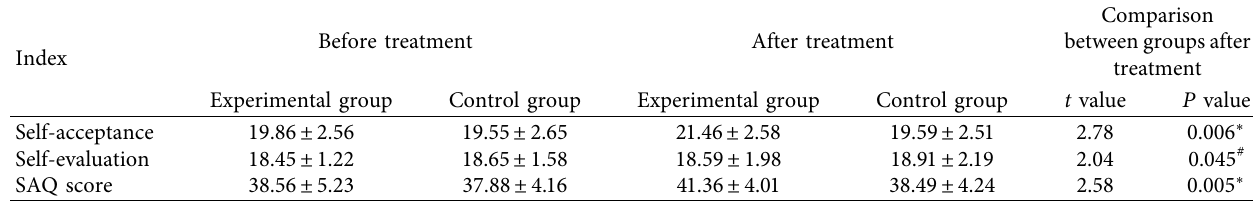
Table 3: Comparison of the scores of the SAQ scale between the experimental group and control group before and 8 weeks after treatment. Index